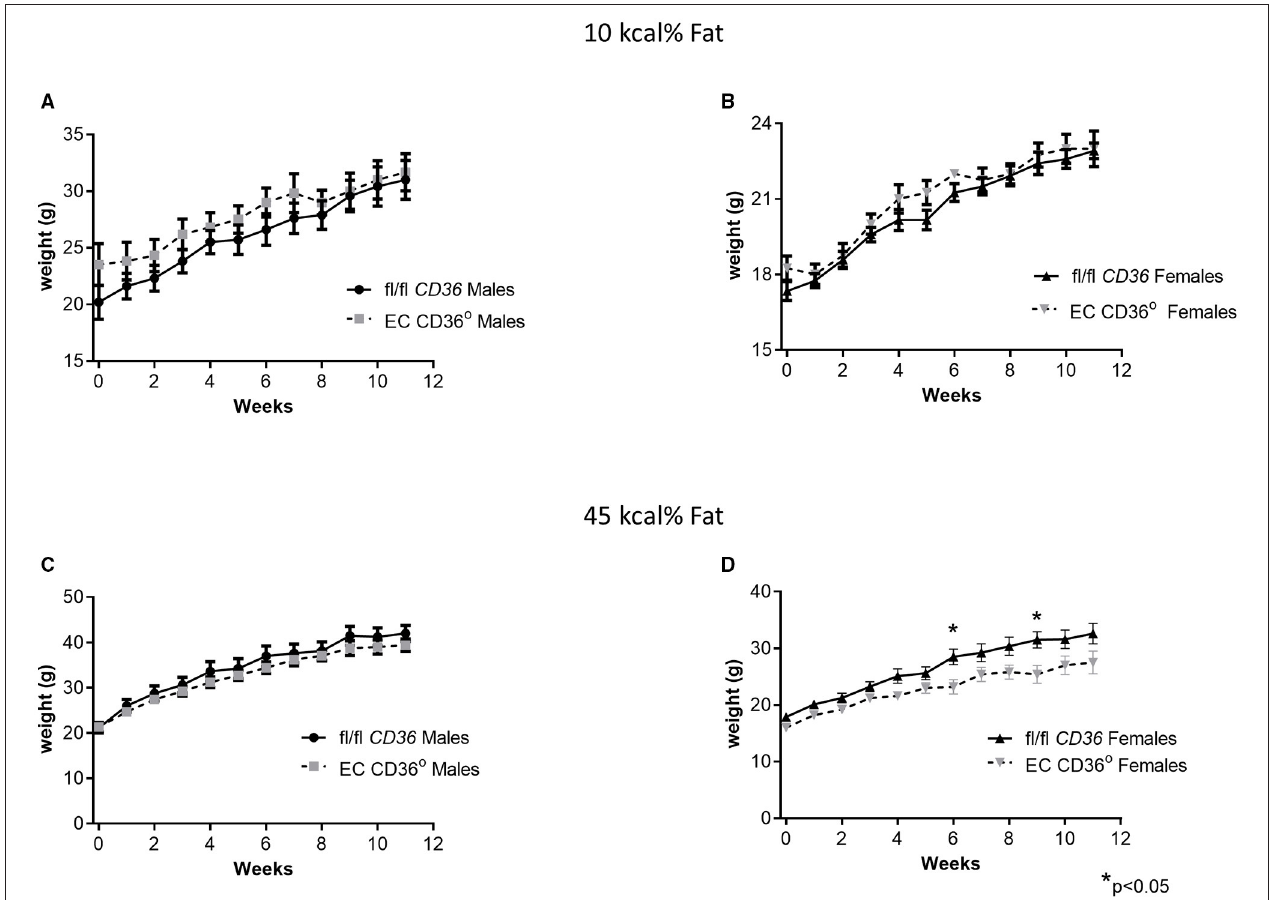
FIGURE 4 | Change in weight over time of EC CD36 ◦ and fl/fl CD36 mice fed with ingredient-matched diets. (A) Male mice fed with the 10 kcal% fat diet. (fl/fl CD36 , n = 10; EC CD36 ◦ , n = 6). (B) Female mice fed with the 10 kcal% fat diet (fl/fl CD36 , n = 12; EC CD36 ◦ , n = 4). (C) Male mice fed with the 45 kcal% fat diet. (fl/fl CD36 , n = 8; EC CD36 ◦ , n = 9). (D) Female mice fed with the 45 kcal% fat diet (fl/fl CD36 , n = 12; EC CD36 ◦ , n = 5). There was a significant difference in weight at the 6 and 9 week time